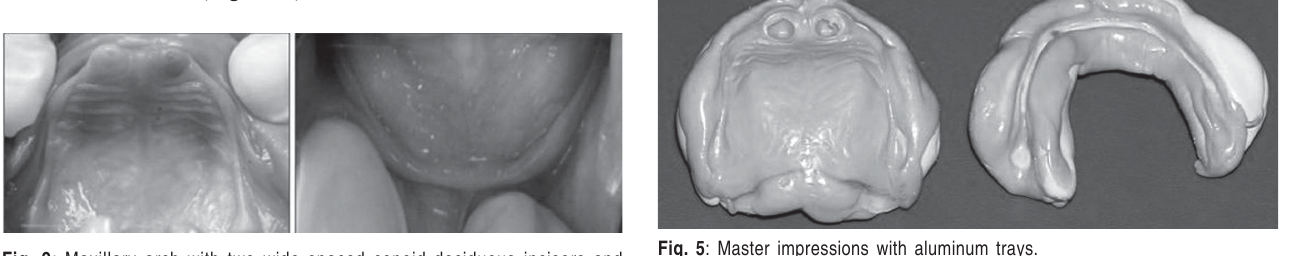
Fig. 2 : Maxillary arch with two wide spaced conoid deciduous incisors and completely edentulous mandibular arch.